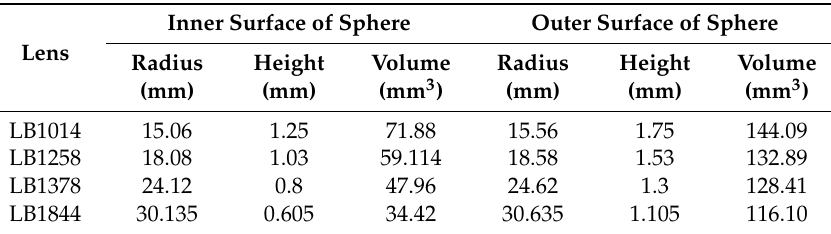
Table 1. Specification of imaging system for simulation.